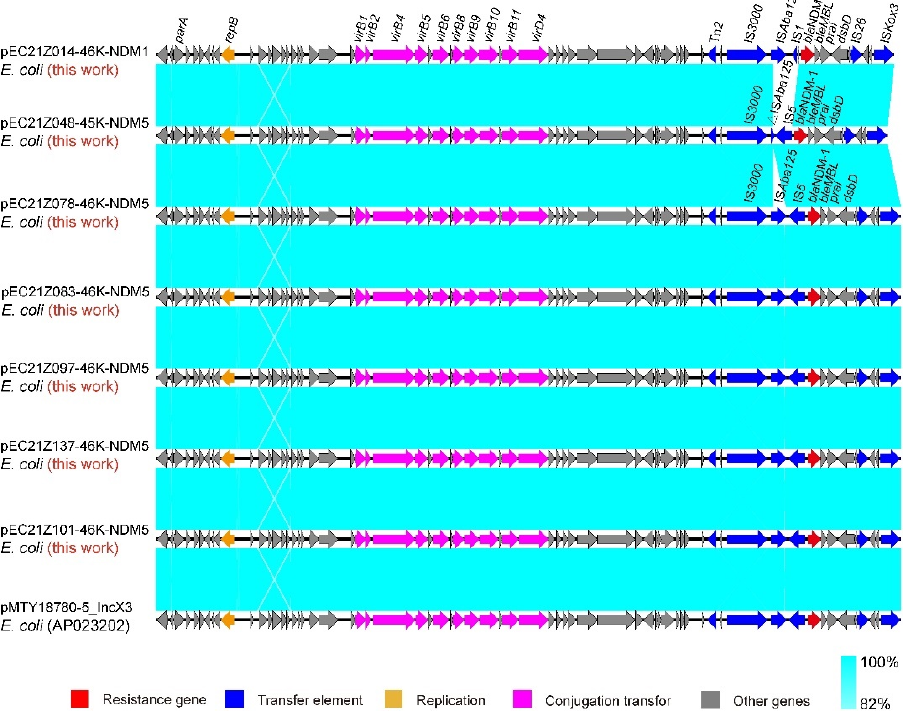
Figure 6. Sequence comparison of the IncHI2A plasmids carrying bla NDM-5 genes from the strains EC21Z-144 and EC21Z-151. The original plasmid (pSal8934) is compared with the pEC21Z144-121K- NDM5 and pEC21Z151-128K-NDM5. The shufflon regions are marked by a green box, and the box marking A, B, C and D referred to the four segments of shufflon. The arrows and triangles represent genes from different functional categories (red: ARGs, dark blue: insertion sequence, orange: repli- cation, pink: conjugation transfer, green: shufflon region, grey: other genes).